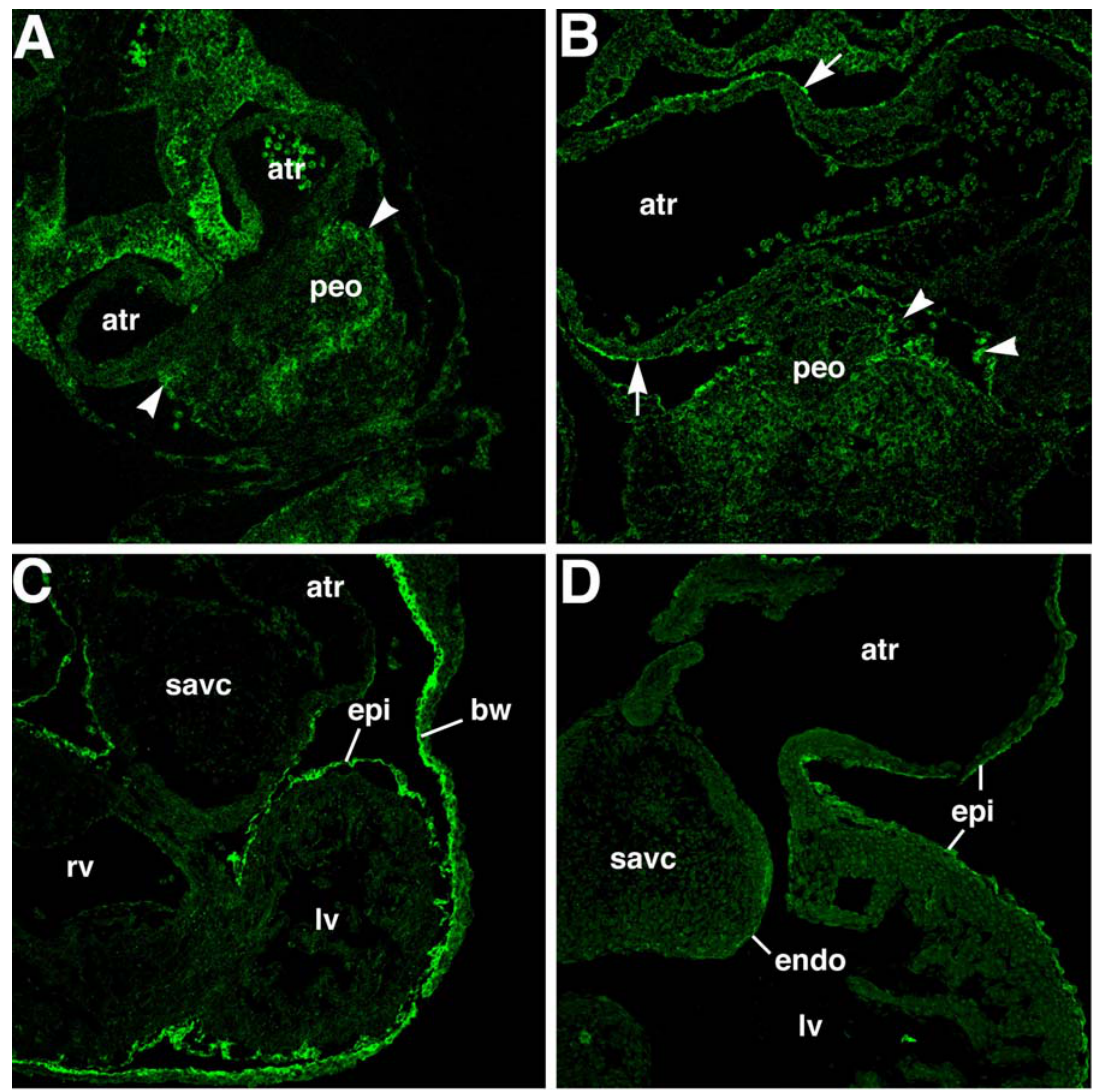
FIGURE 2. RALDH2 immunolocalization in the embryonic mouse heart labels both proepicardium and epicardium. Sections from embryonic day 9.5 (A), 10.5 (B), 11.5 (C), and 12.5 (D) mouse embryos immunostained against RALDH2 show immunolocalization in the proepicardium (peo) at E9.5 and E10.5 (panel A and B, arrowheads), as well as newly formed epicardium at E10.5 (panel B, arrow). Note that regions of myocardium devoid of proepicardium-derived cells do not express RALDH2. By E11.5, the heart is covered with epicardium (epi) and expresses RALDH2 over its entire surface. RALDH2 immunolocalization is also observed in an epithelial layer adjacent to the body wall (bw) and likely represents the developing pericardium. RALDH2 continues to be expressed in the epicardium and subepicardial cells at E12.5 (panel D), as well as in the endocardium (endo) over the atrioventricular valve